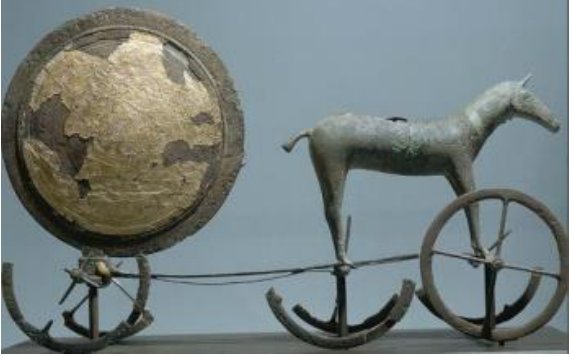
Figure 1. Trundholm Sun Chariot , c. 1700 BC. Bronze, 54 × 35 × 29 cm. National Museum of Denmark , Copenhagen. Image © Gianni Dagli